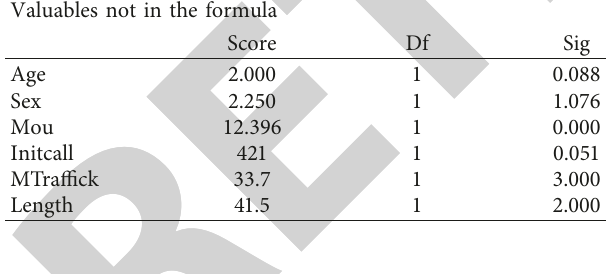
Table 4: Results of network access duration indicators.